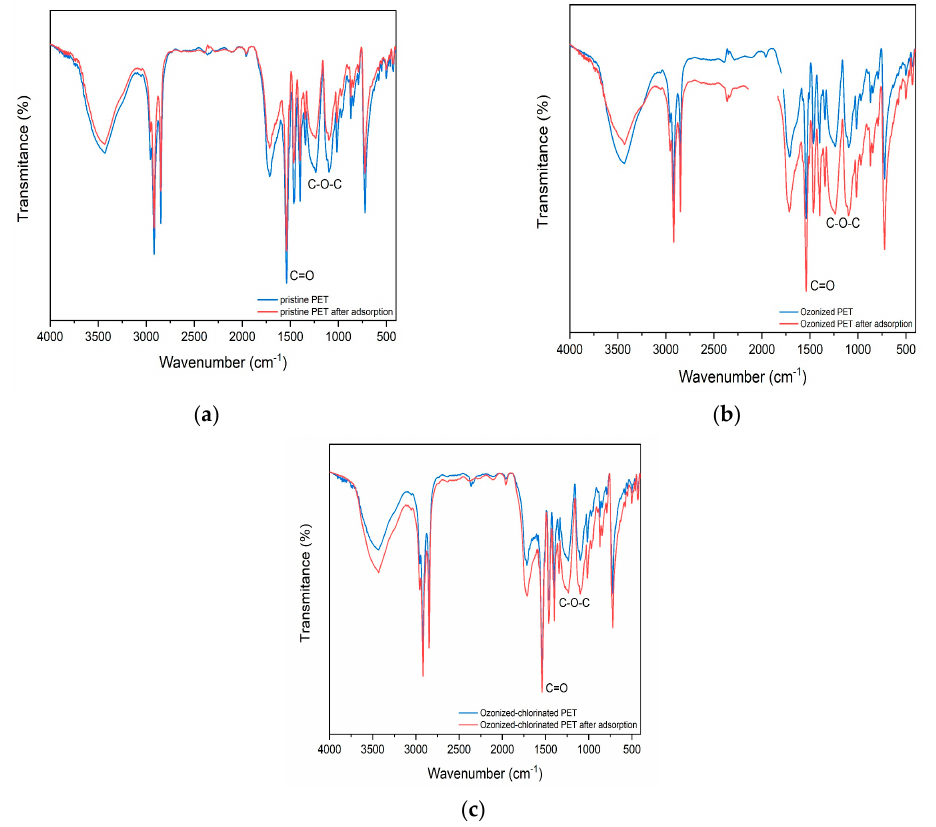
Figure 11. The FT − IR spectra of the PET with different treatments before and after absorption ( a )